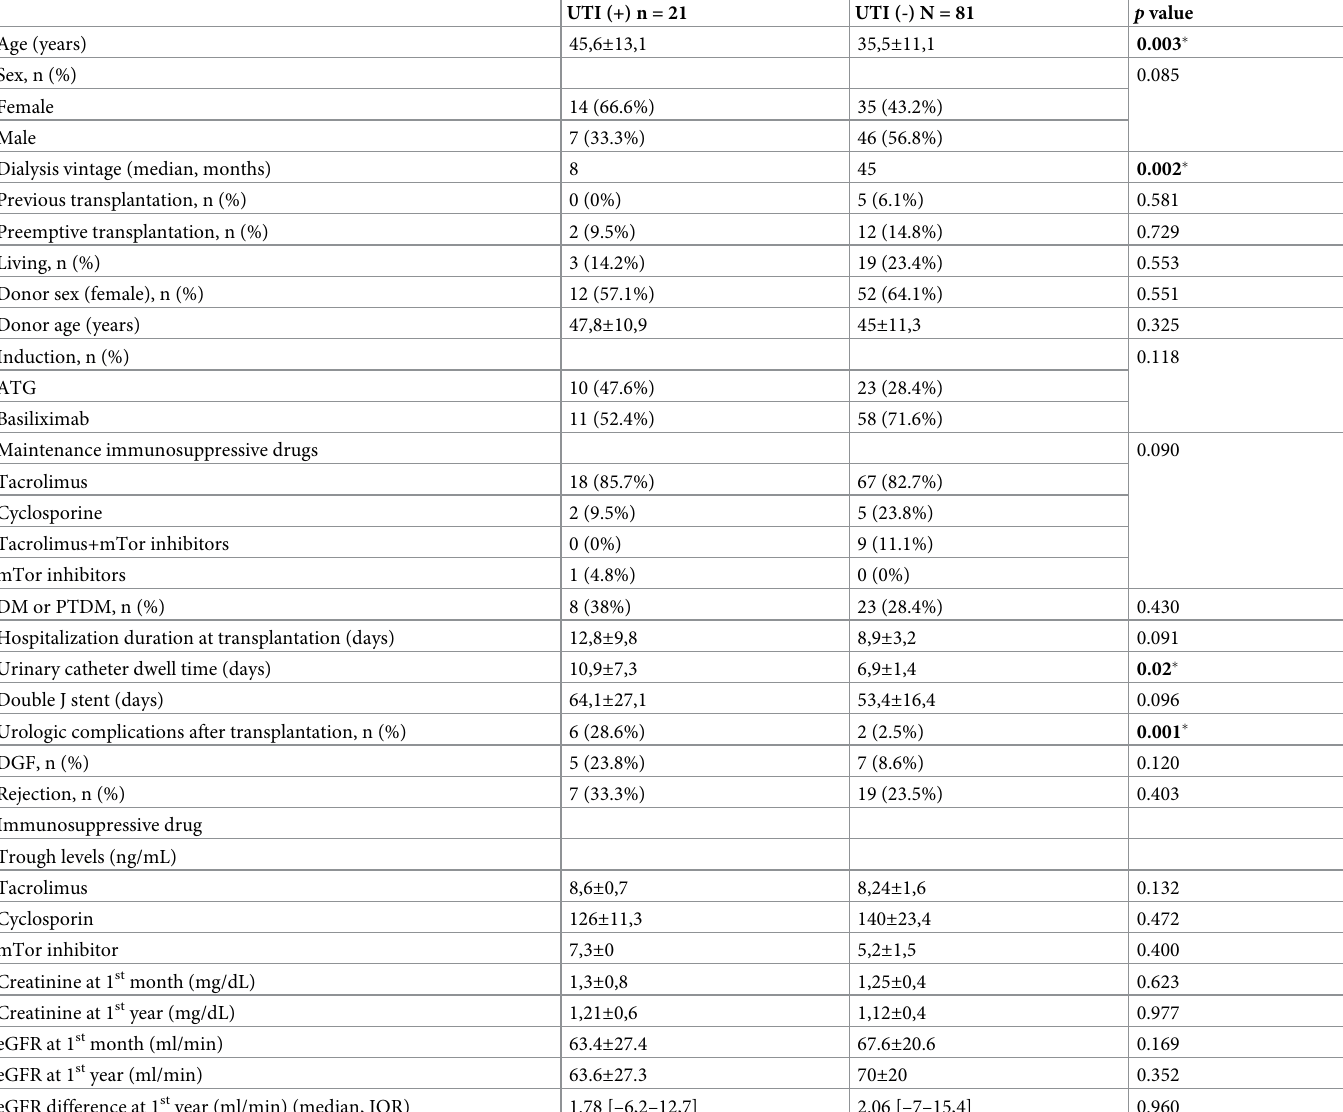
Table 1. Demographic and clinical data in patients with or without Urinary Tract Infections